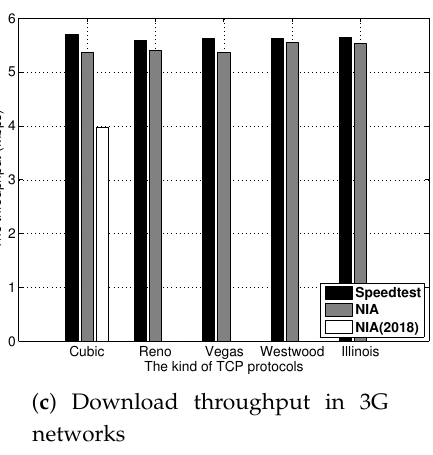
Figure 4. Measured throughput in Long-Term Evolution (LTE) and 3G networks for different Transmission Control Protocols (TCPs). ( a ) Download and ( b ) upload throughput in LTE networks and ( c ) download and ( d ) upload throughput in 3G networks.